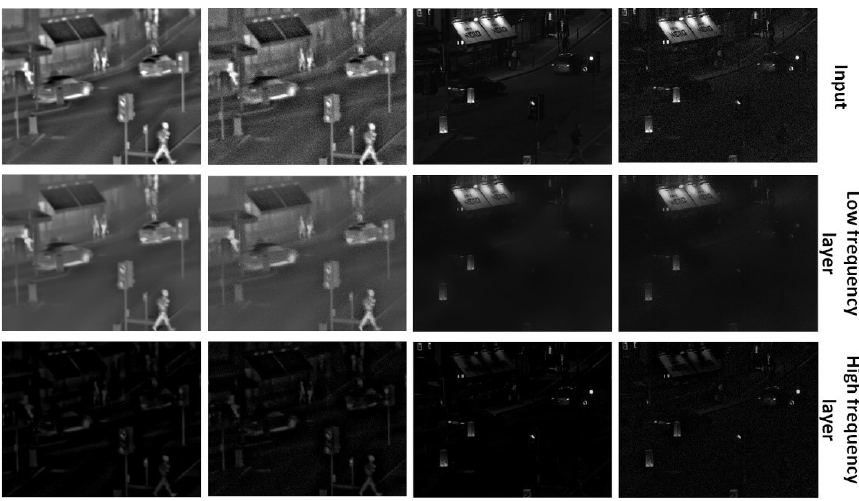
Figure 3. Two-scale decomposition image.